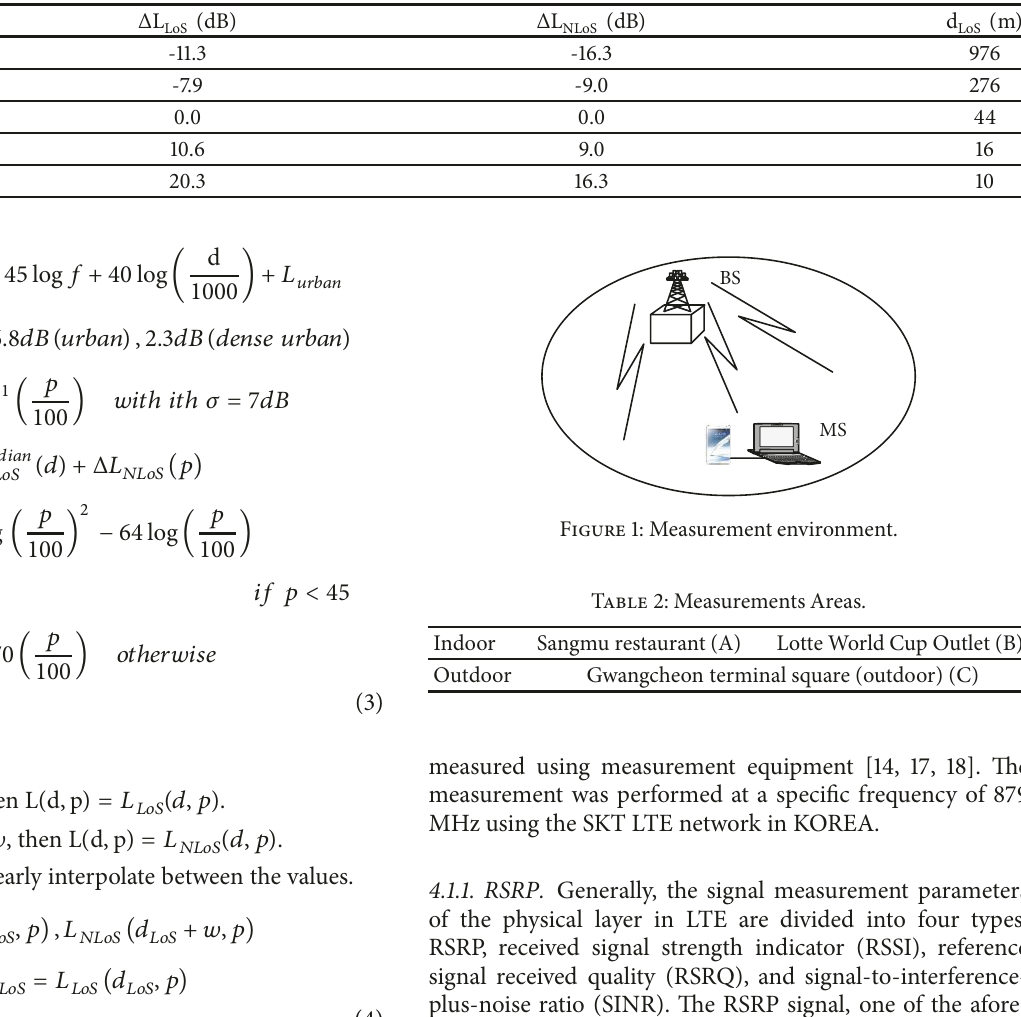
Table 1: LoS and NLoS location variability corrections [15].